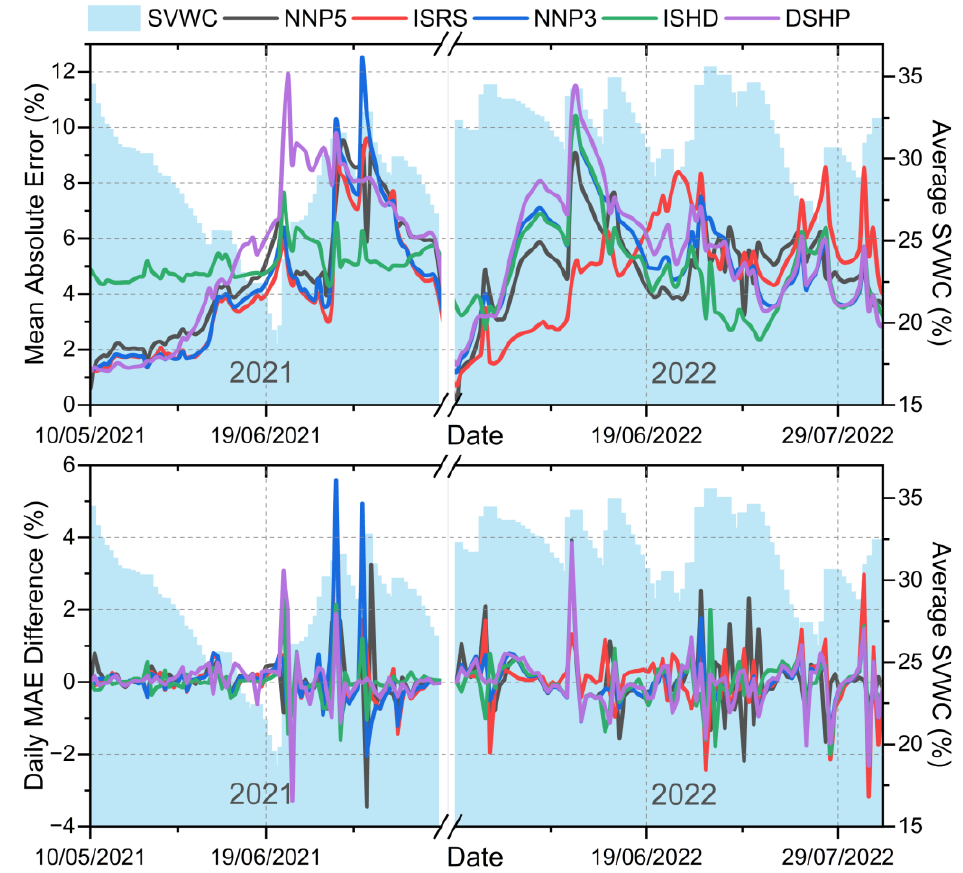
Figure 9. Variation characteristics of the model simulation error in the time dimension.